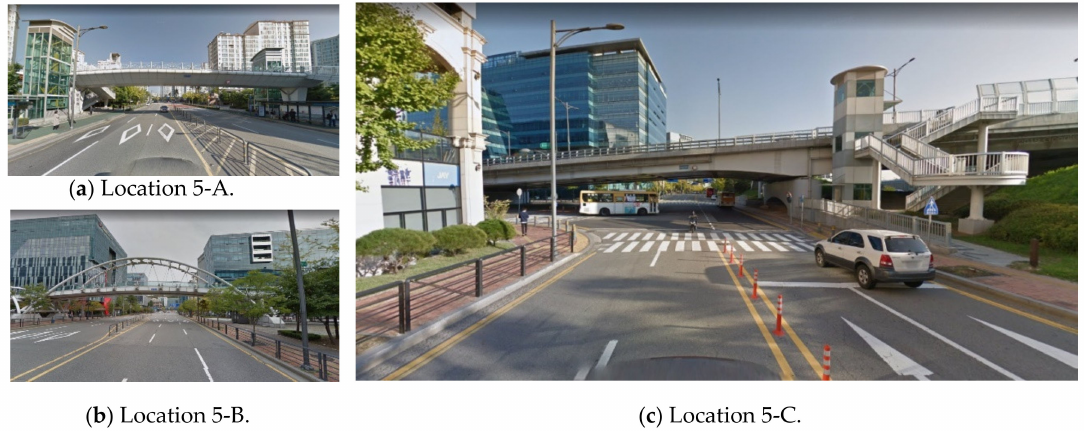
Figure 17. Overpasses at which the VPD suddenly changes (Naver Maps